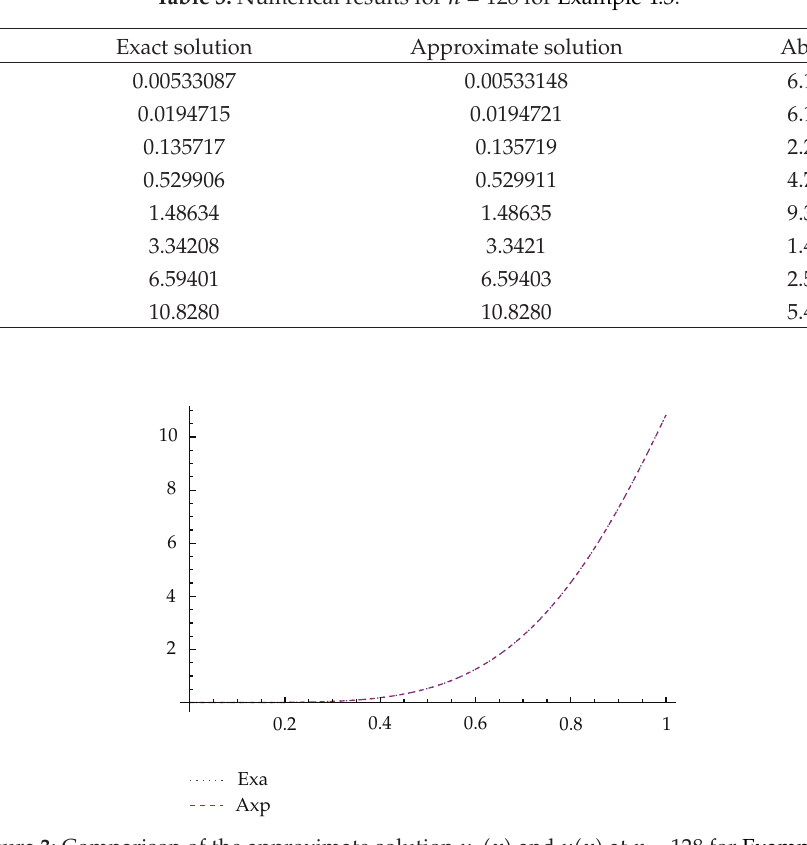
According to the numerical scheme above, one can obtain the approximation u n (cid:6) x (cid:7) of u (cid:6) x (cid:7) for n (cid:9) 128. The numerical results are displayed in Table 3 and Figure 3, which show that